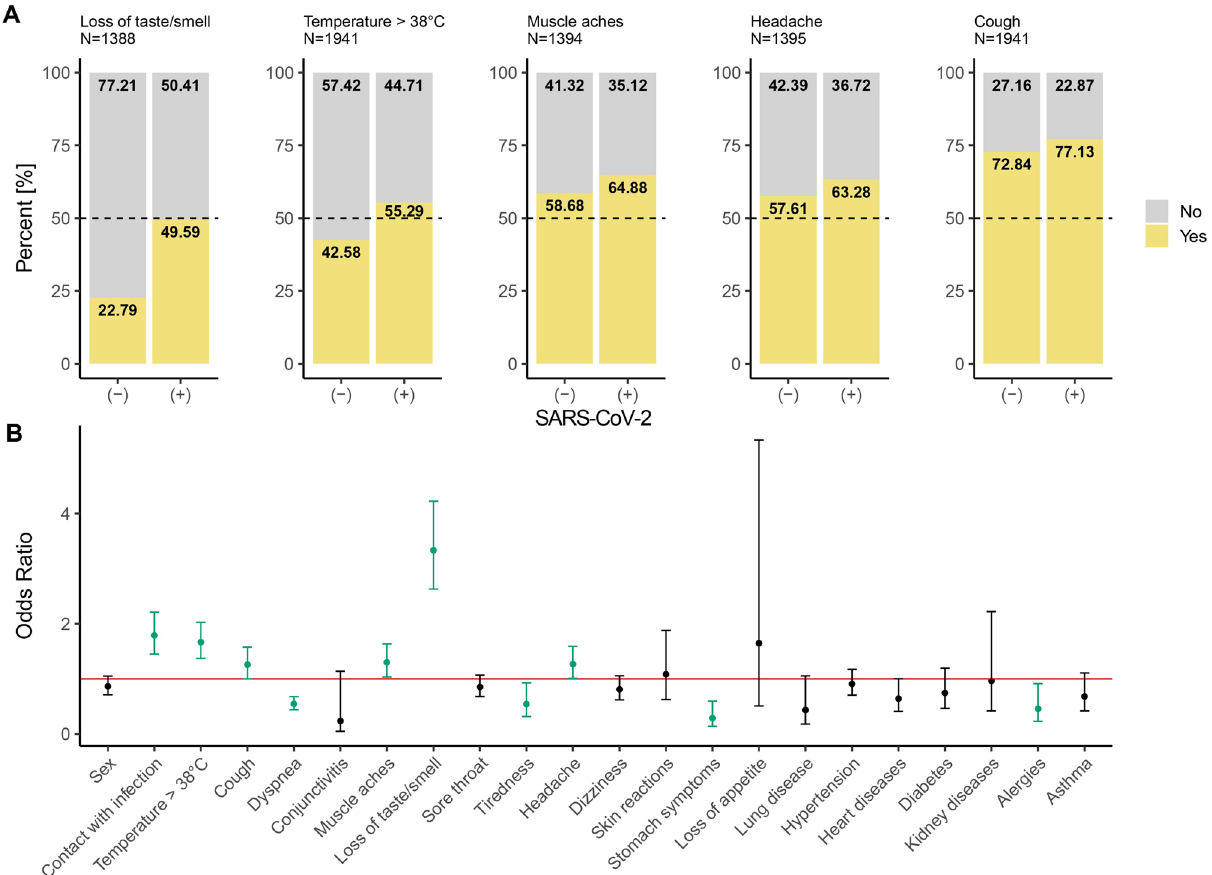
Figure 1. Results of statistical analysis. Panel A stacked bar plots showing frequencies of symptoms regarding COVID-19 diagnosis. Symptoms having a higher odds ratio in SARS-CoV-2 infected patients were shown. Panel B odds ratio for all symptoms and coexisting diseases with 95% confidence intervals. The red line shows the level of odds ratio equal to 1. Significant odds ratios were coloured